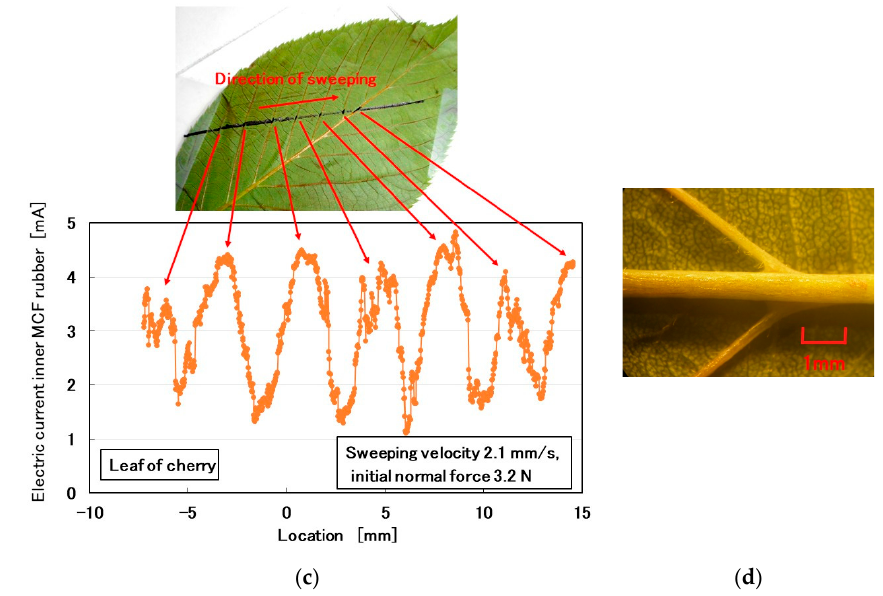
Figure 19. Rubbing the back of plant leaves using the MCF rubber sensor: ( a ) surface roughness of hydrangea leaf; ( b ) microscopic image of the hydrangea leaf; ( c ) surface roughness of cherry leaf; ( d ) microscopic image of the cherry leaf.